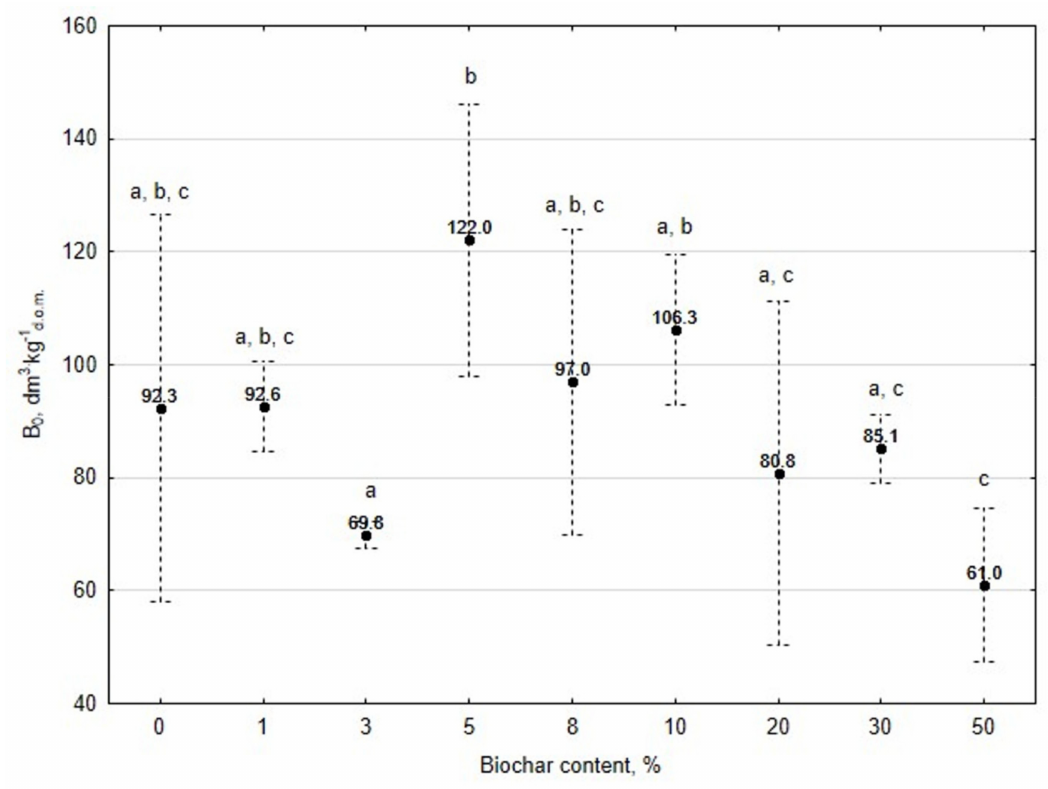
Figure 3. The e ff ect of biochar (BC) mass content (%) addition to brewer’s spent grain (BSG) digestion on maximum production of biogas from the substrate ( B 0 , dm 3 · kg − 1 d.o.m. ). Letters denote significant di ff erences ( p < 0.05) between mean